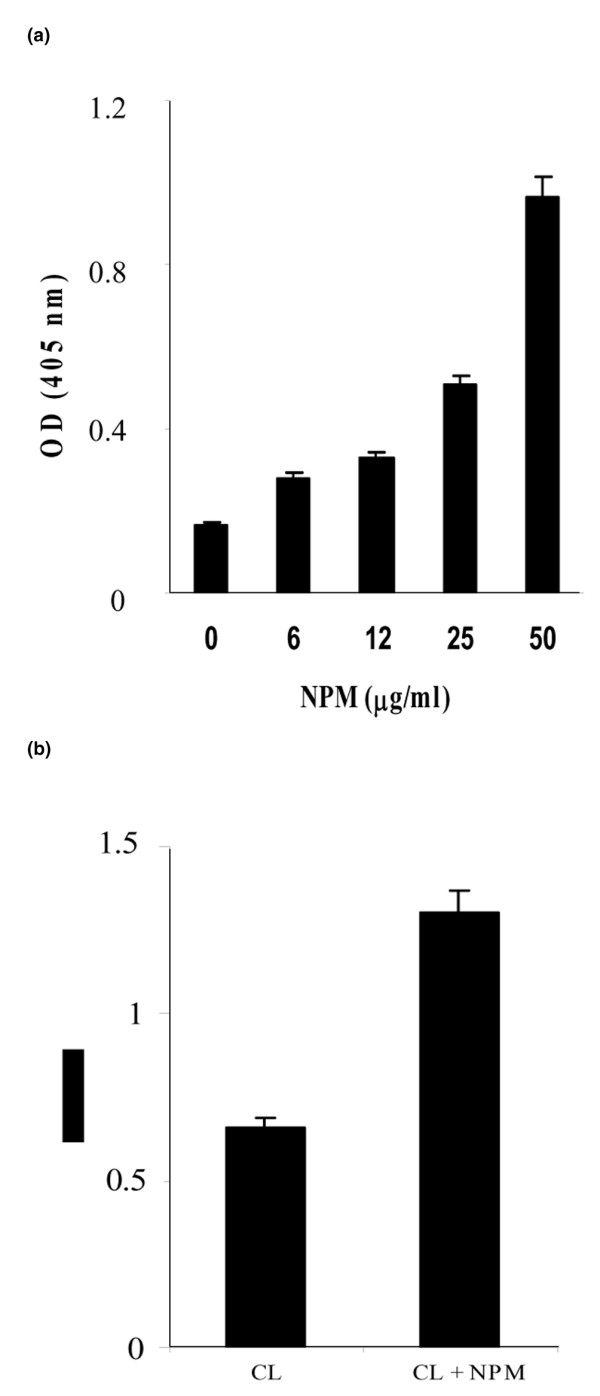
Binding of rhNPM to cardiolipin and effects of nucleophosmin on cardiolipin-binding activity of 4B7 mAb. (a) Cardiolipin was coated on plastic plates and incubated with various concentrations of recombinant human nucleophosmin (rhNPM). (b) mAb 4B7 was incubated on cardiolipin-coated plates in the absence or presence of rhNPM. Bars represent the mean A405 of duplicate experiments and error bars represent SD.